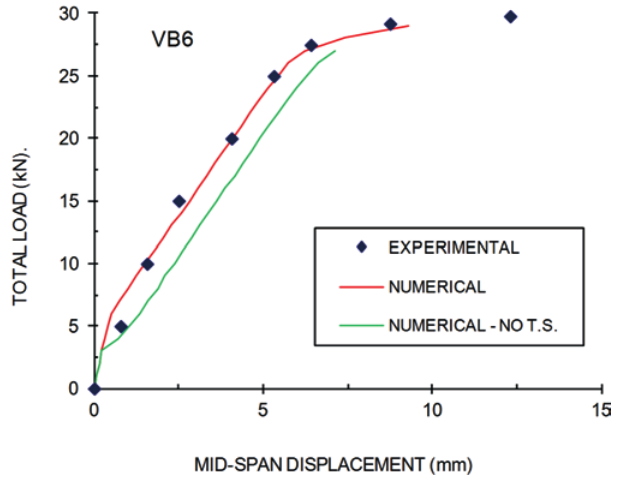
Comparison between numerical (ANEST/CA) and experimental results for beam VB6 tested by Juvandes